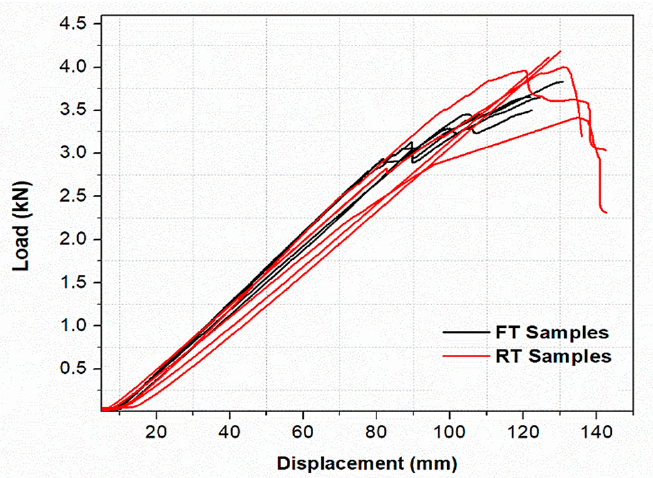
Figure 4. The short-term test results of RT samples and FT samples.